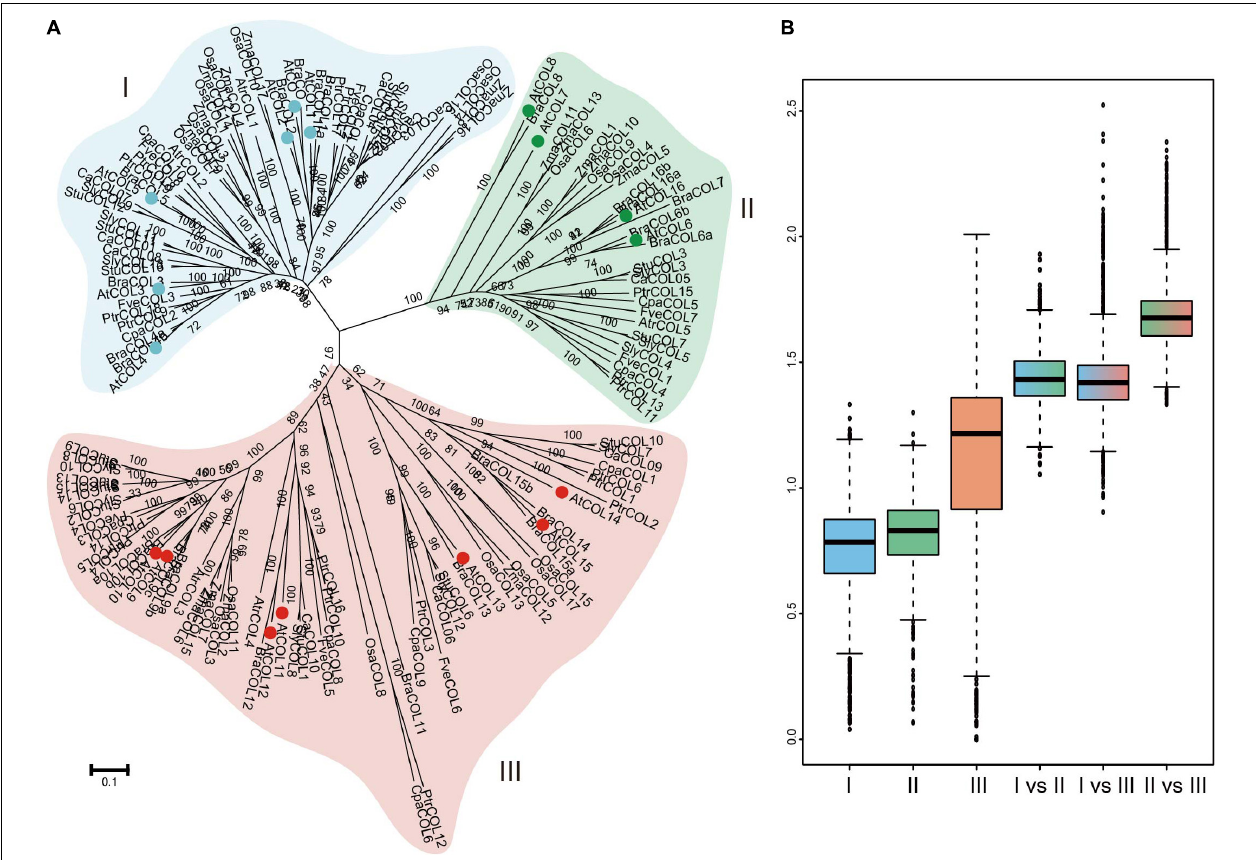
FIGURE 5 | Phylogenetic relationship of COL gene family members in 12 selected plant species (A) and nucleotide distance of group I, II, and III COL genes (B) . Group I, II and III of AtCOLs are indicated by blue, green and red balls,